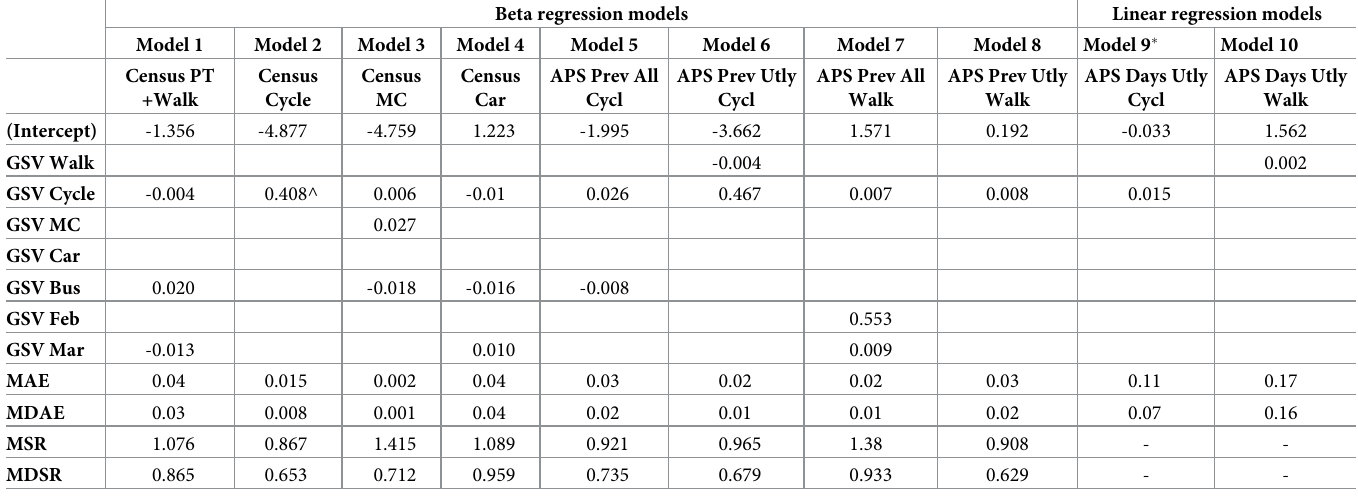
Table 2. Regression models. Beta regression models Linear regression